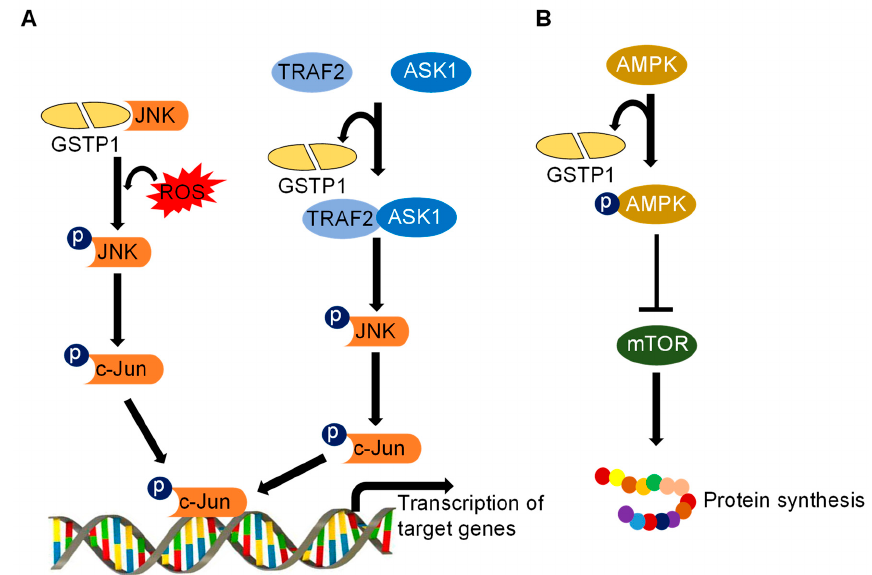
Figure 2. Multifarious roles of GSTP1 in cell signaling. ( A ) Under oxidative stress, the interaction between GSTP1 and c-Jun N-terminal kinase 1 (JNK1) is deterred and leads to phosphorylation of c-Jun and transcription of target genes. Similarly, in the absence of GSTP1, tumor necrosis factor (TNF)-receptor-associated factor 2 (TRAF2), and apoptosis signal-regulating kinase (ASK1) interact and cause phosphorylation of c-Jun. ( B ) Phosphorylation of 5’ adenosine monophosphate-activated protein kinase (AMPK) in GSTP1 knockdown cells inhibits the mechanistic target of rapamycin (mTOR) pathway and impairs protein synthesis.